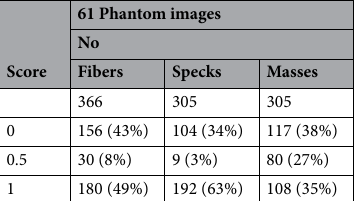
Table 3. External validation set data status and